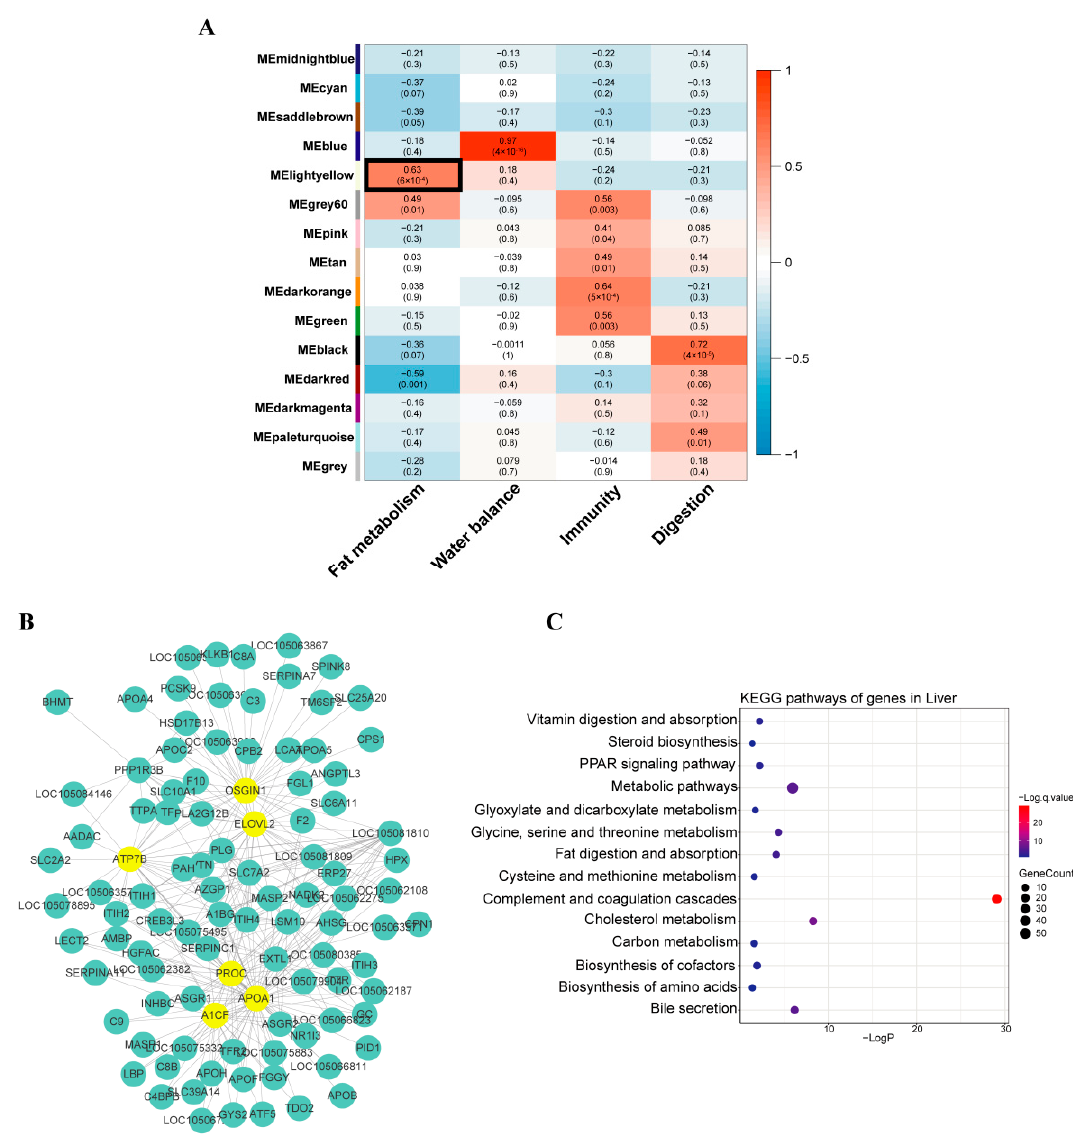
Figure 2. Weighted gene co ‐ expression network analysis (WGCNA) of genes associated with adap- tation to desert environments in adult camels. ( A ) Heatmap of the correlation of module genes with fat metabolism, water balance, immunity, and digestion. ( B ) Gene network of the top 300 genes in the light yellow module. Yellow circles correspond to hub genes with a degree of connectivity greater than 25. ( C ) KEGG pathway analysis of genes in light yellow module that overlapped with liver tissue ‐ elevated genes.